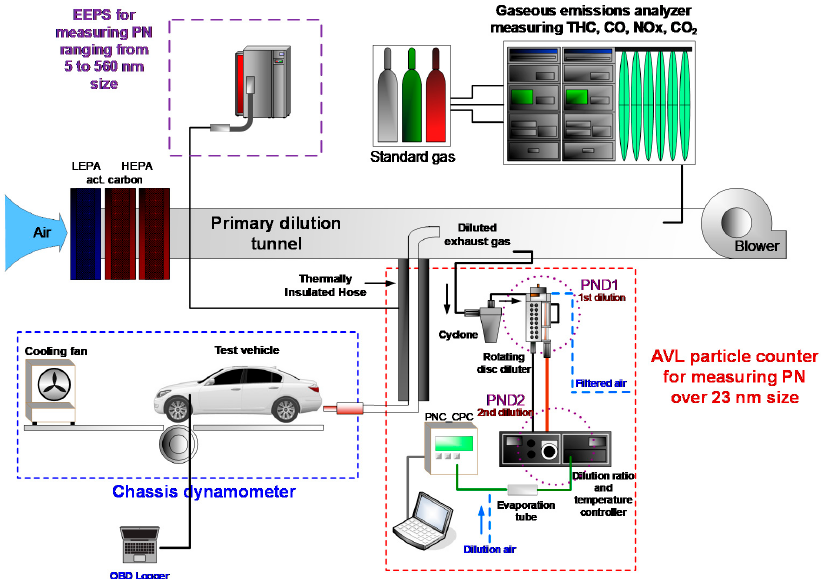
Figure 1. Schematic diagram of the experimental apparatuses.